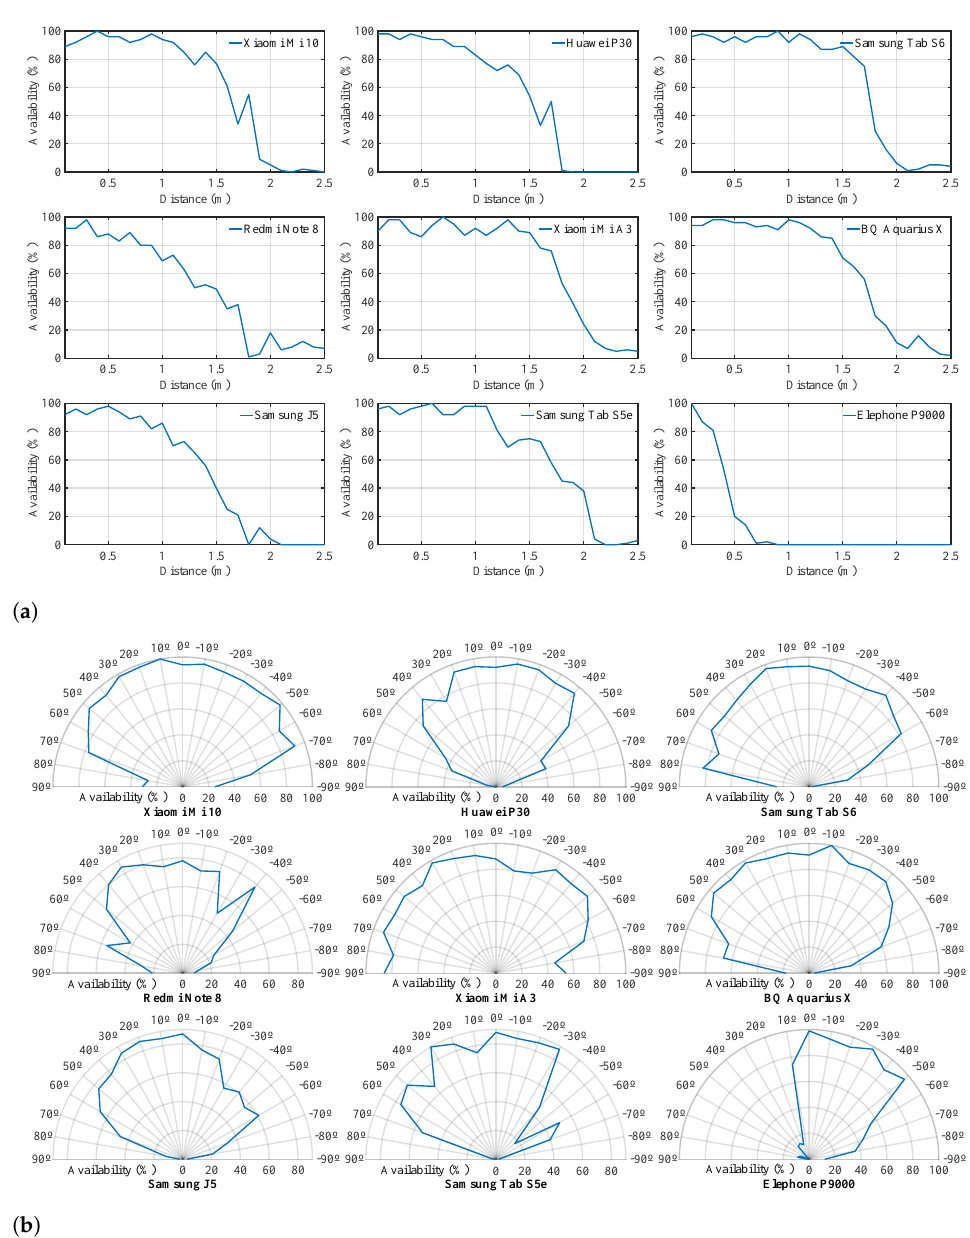
Figure 9. Sensing coverage experimental results. ( a ) Availability versus distance. ( b ) Availability versus angle at 1